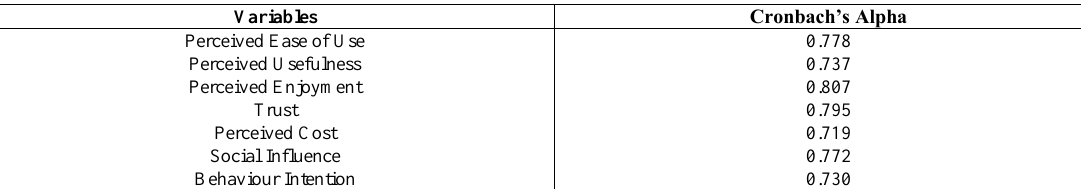
Table 2. Reliability